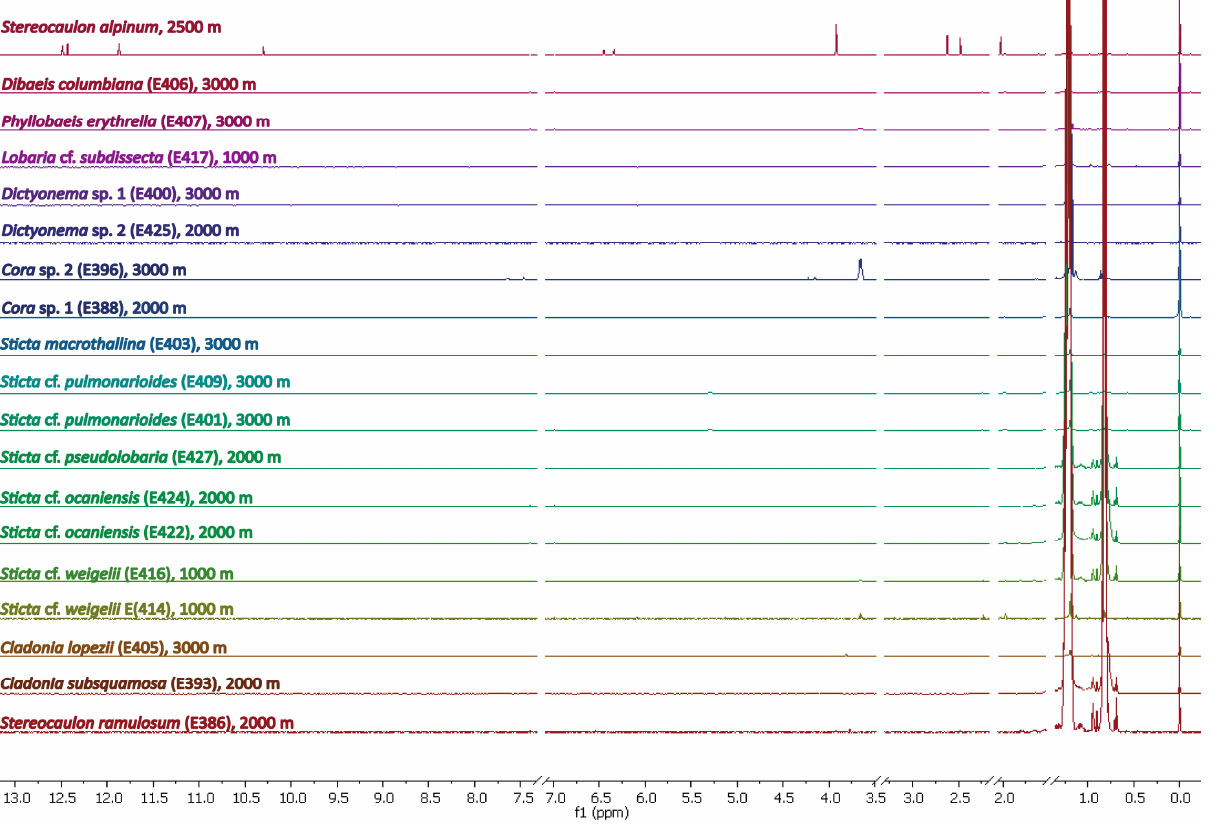
Figure 1. 1 H-NMR spectra of hexane extracts of S. alpinum (top trace) and some Ecuadorian lichens between 0.0 and 13.0 ppm. “Unspecific” signals due to solvents were omitted. Spectra were scaled to the signal intensity of CHCl 3 from the